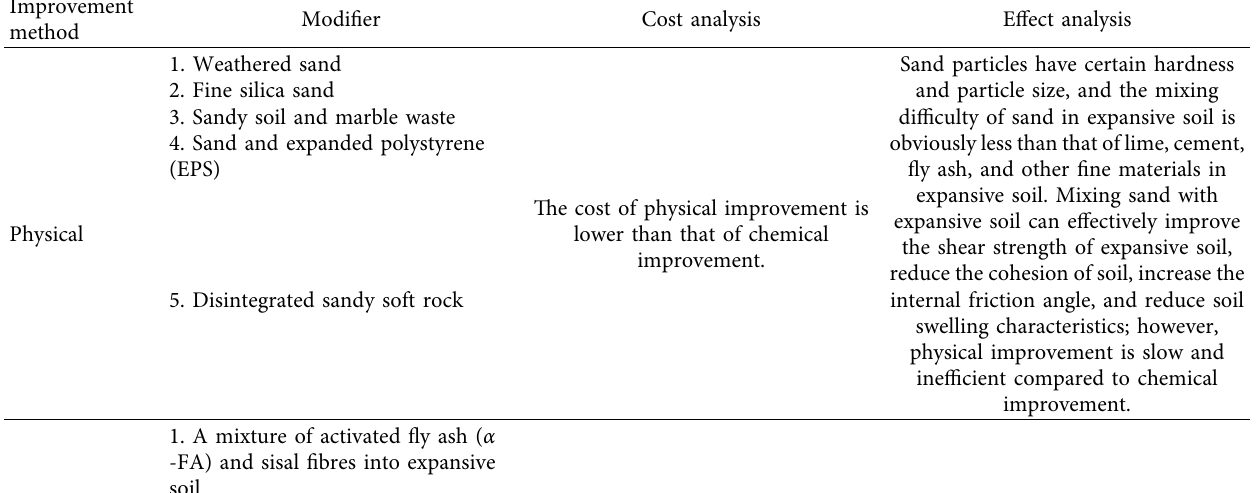
Table 5: Summary of the effect and cost analysis of different improvement